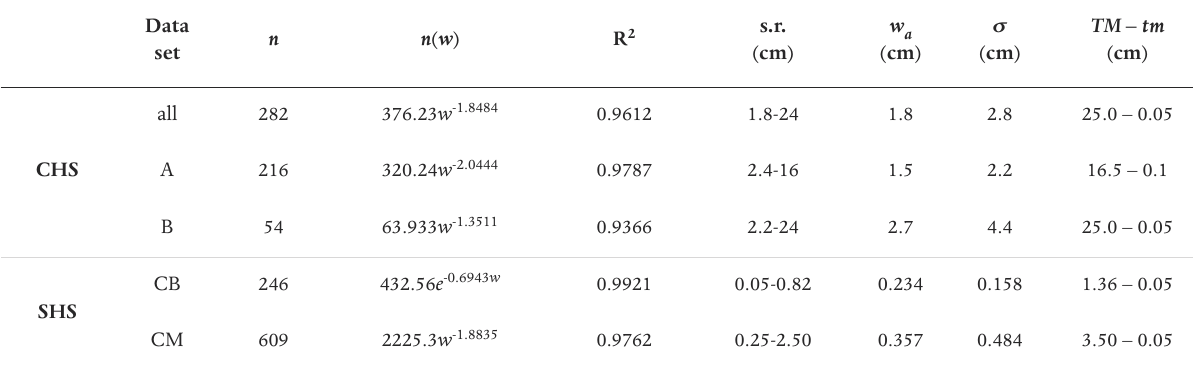
Table 1. Distribution and statistics of veins in the studied hydrothermal systems. n : sample number; n ( w ): cumulative distribution, number of veins with width larger than w ; R 2 : goodness of fit; s.r.: size range of distribution; w